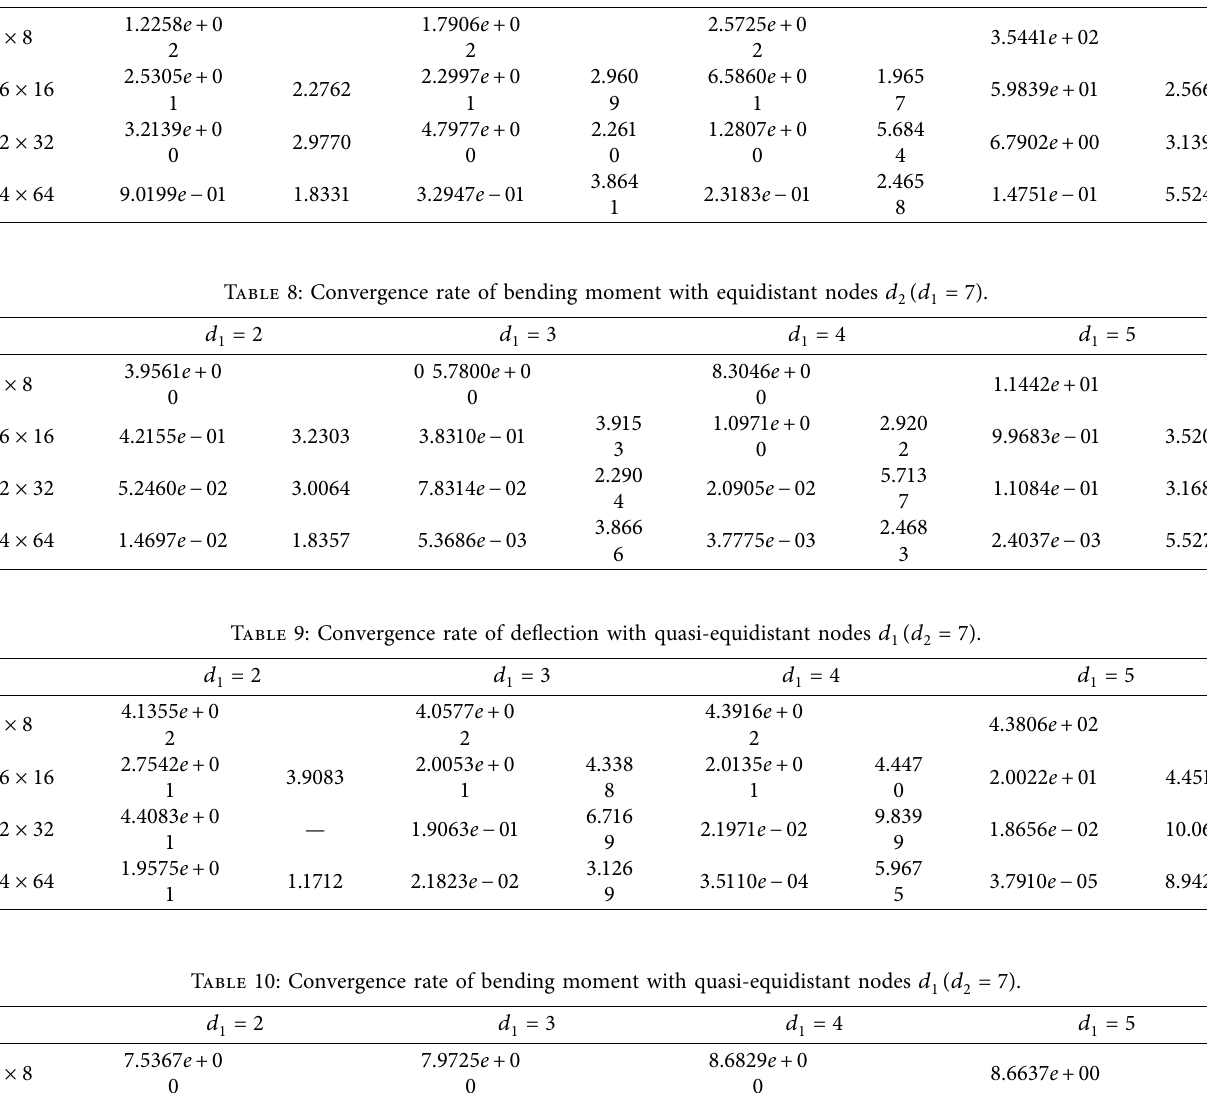
Table 7: Convergence rate of deflection with equidistant nodes d